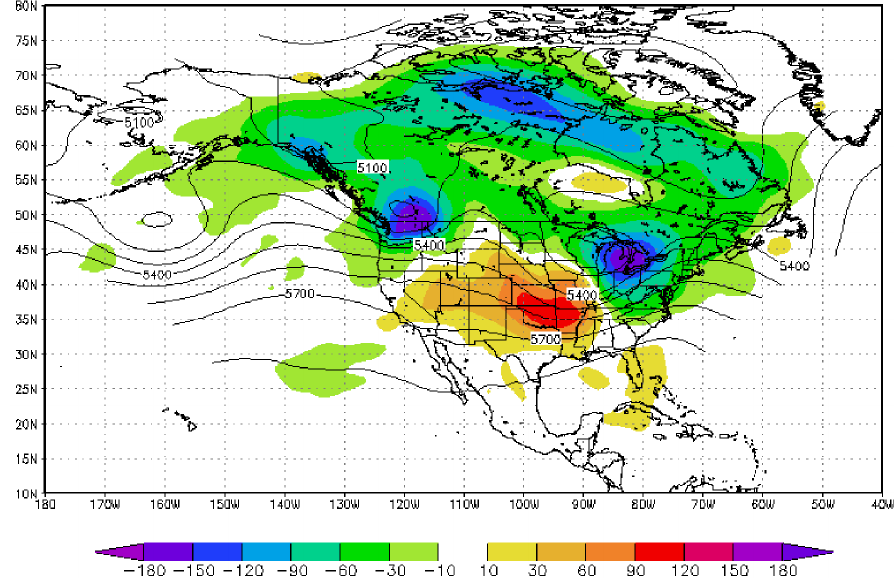
Fig. 3. A snapshot of the high-resolution perturbation component of the truth in the limited area domain (color shades). Shown is the 500hPa geopotential height component of the perturbation after 16 days of model integration. Also shown is the low resolution global component of the 500hPa “true” geopotential height field